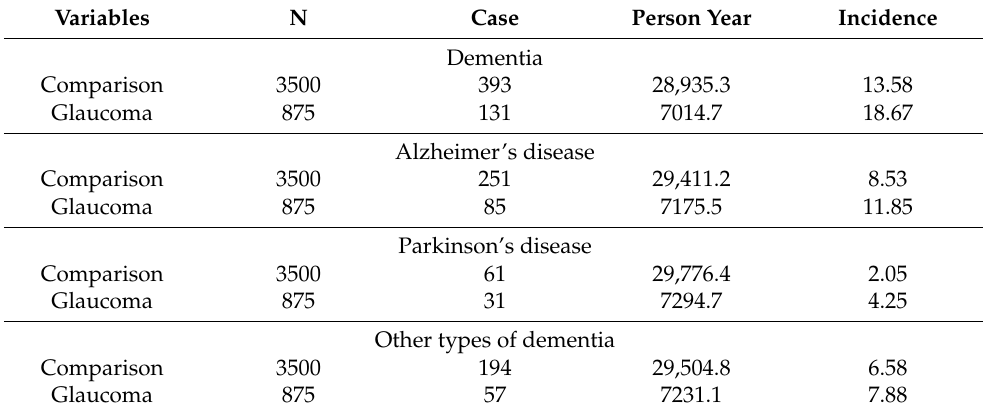
Table 2. The incidence rate of dementia between glaucoma and comparison (non-glaucoma)